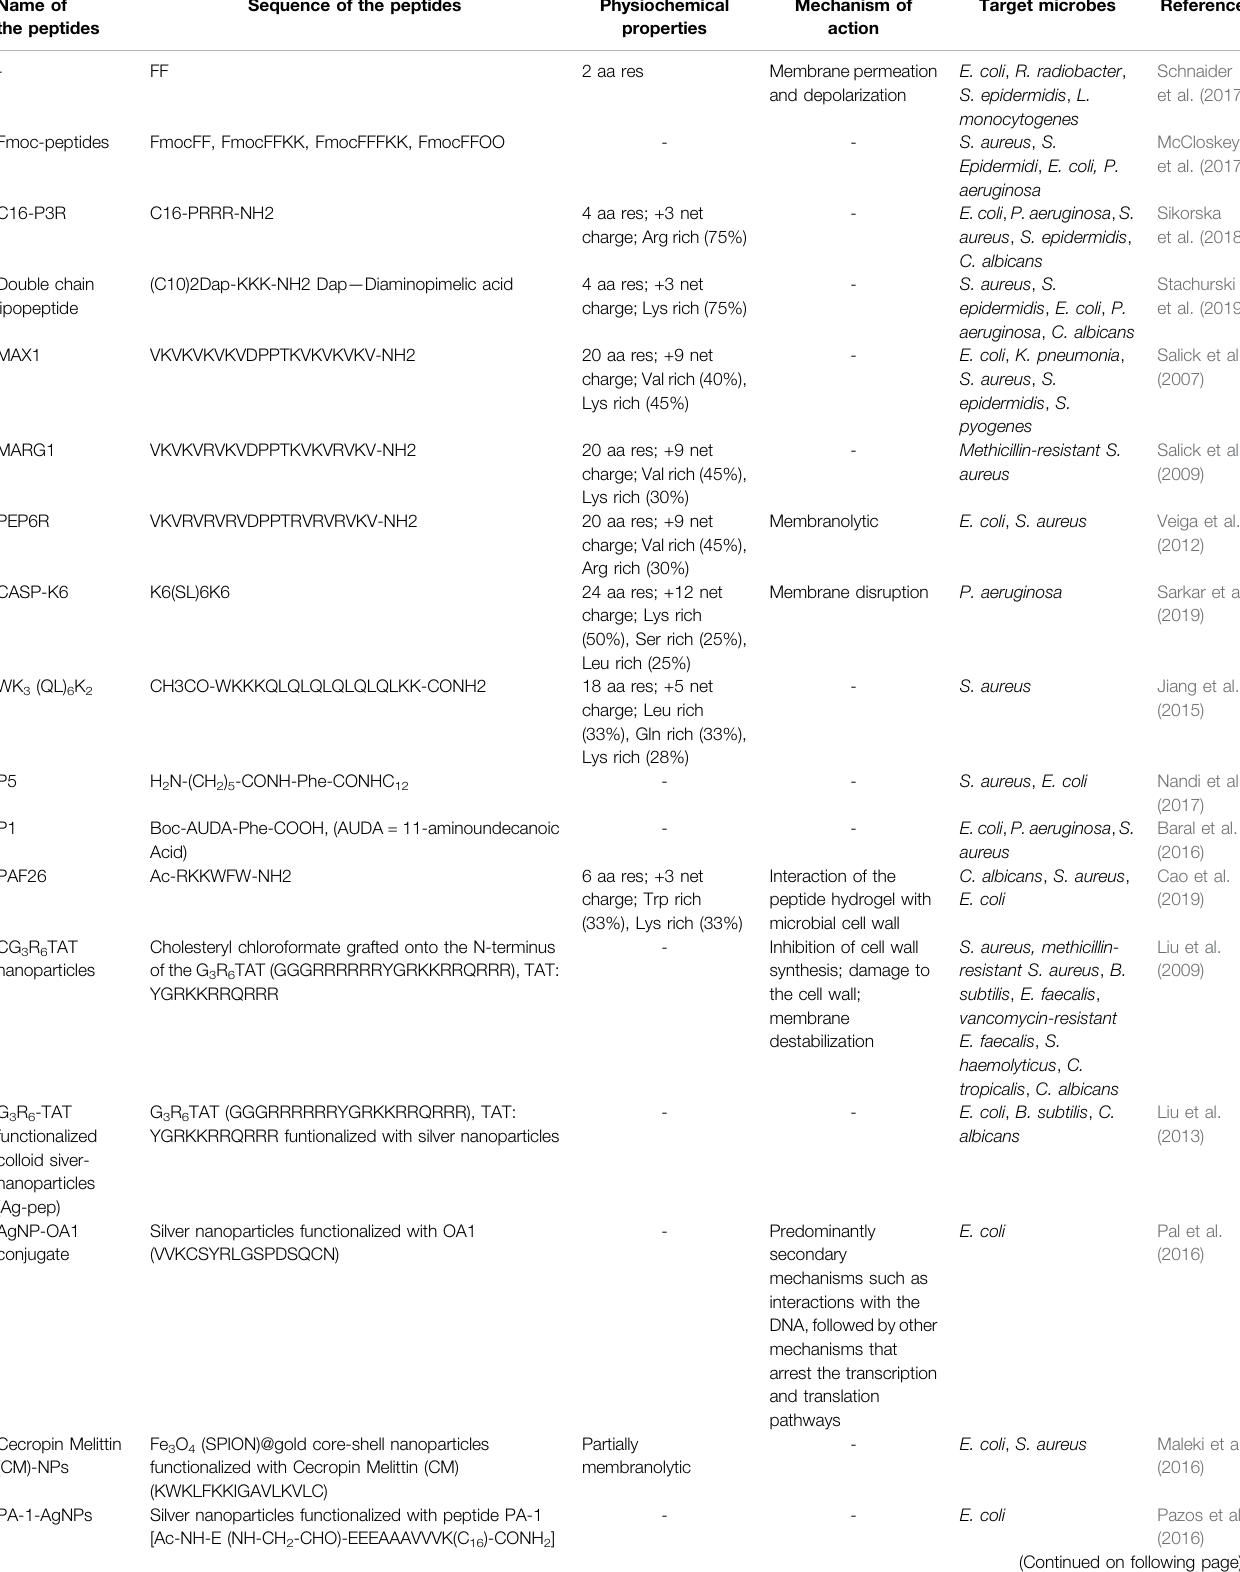
TABLE 3 | Antimicrobial peptides: delivery vehicles, peptide hydrogels and peptide-nanoparticle